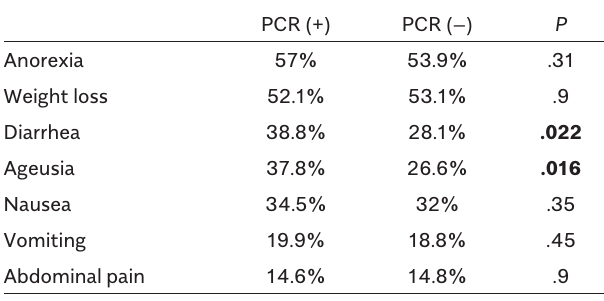
Table 3. The Prevalence of Gastrointestinal Symptoms According to PCR Test Positivity PCR (+) PCR ( − ) P Anorexia